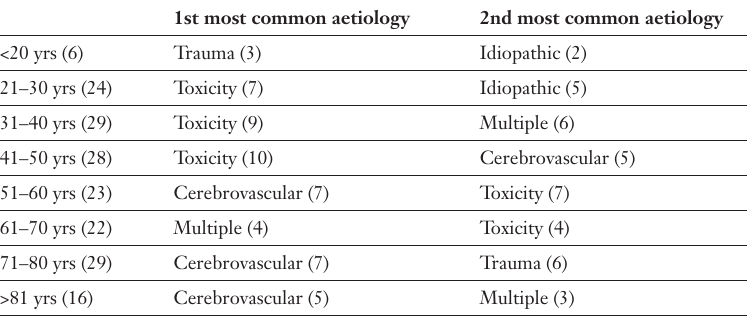
2 most common aetiologies as per relative importance and in relation to patient age (absolute number in